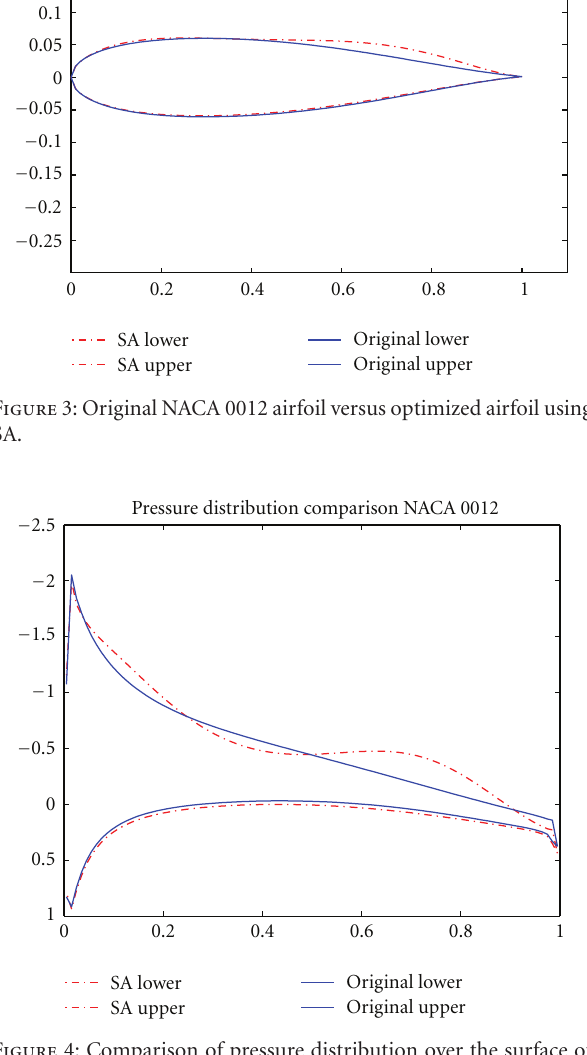
Figure 6: Comparison of pressure distribution over the surface of original NACA 0012 airfoil and optimized airfoil using